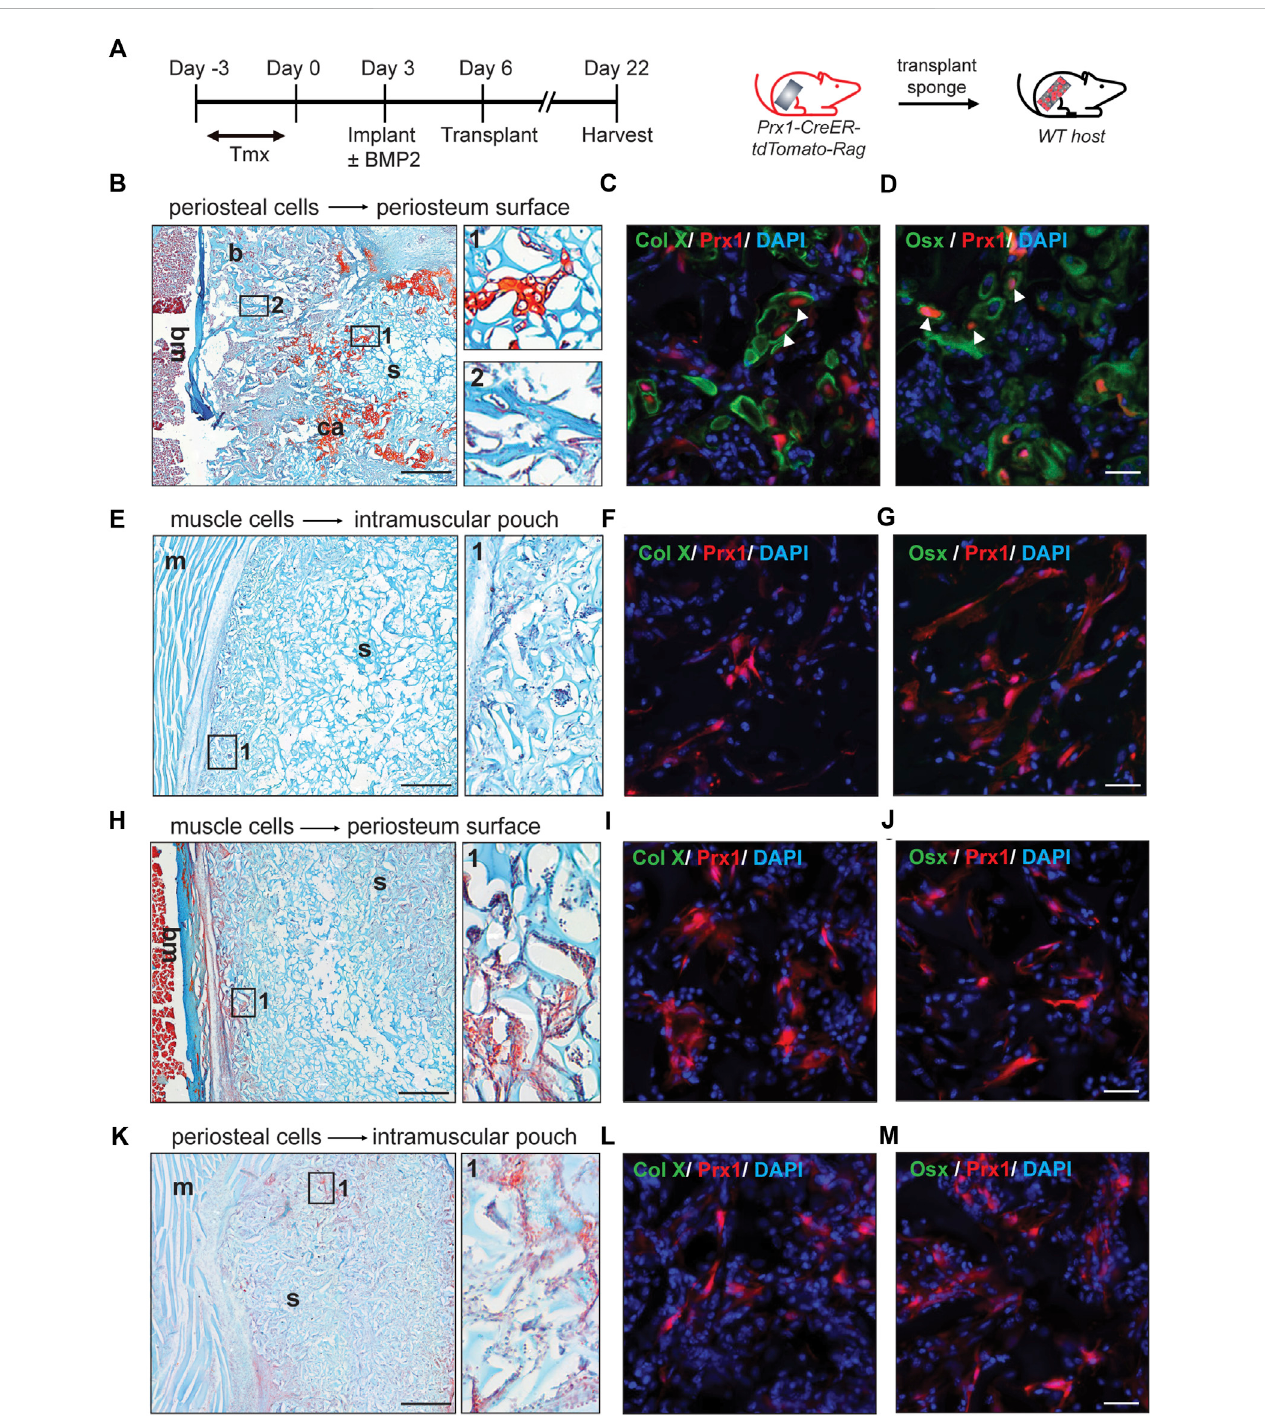
FIGURE 2 Reaction of periosteal and muscle-derived cells to 0.5 µg BMP2 upon transplantation to the same or different environment. (A). Timeline and schematic representation of sponge implantation in hindlimbs of Prx1-CreER-tdTomato-Rag donor mice and subsequent transplantation to B6 host mice. ( n = 3 – 5) (B – D) .Resultsofperiosteual cellsfromPrx1reportermicetransplantedto theperiostealsurfaceofwild-typehosts. (B) longitudinalsectionofthespongeand femur, stained with Safranin O. Right: Enlarged view of boxed regions (1 and 2) shows cartilage and bone formation. (C – D) . High magni fi cation of adjacent section in boxed areas were immunostained with cartilage and osteoblast marker. White arrowheads indicate co-labeling of Prx1 derived cells (red) with Collagen X (green) and Osterix (green), nuclei were labeled with DAPI (blue). (E – G) . Results of muscle cells from Prx1 reporter mice transplanted to the intramuscular pouch of wild-type hosts. Right: Enlarged view of boxed region 1, shows no bone or cartilage formation. (F – G) . Adjacent section immunostained with Collagen X and Osterix (green). (H – J) . Results of muscle cells from Prx1 reporter mice transplanted to the periosteum surface of wild- type hosts. (H) longitudinal section of the sponge and femur, stained with Safranin O. Right: Enlarged view of boxed regions. (I – J). Adjacent section immunostained with Collagen X and osterix (green). (K – M) . Results of periosteum cells from Prx1 reporter mice transplanted to the intramuscular pouch of wild-type hosts. Right: Enlarged view of boxed region 1. (L – M) . Adjacent section immunostained with Collagen X and Osterix (green). Scale bar = 500 μ m for Safranin O, 25um for IF staining. Bm = bone marrow; b = bone; ca = cartilage; s = sponge; m = muscle. Images are representative of 3-5 independent